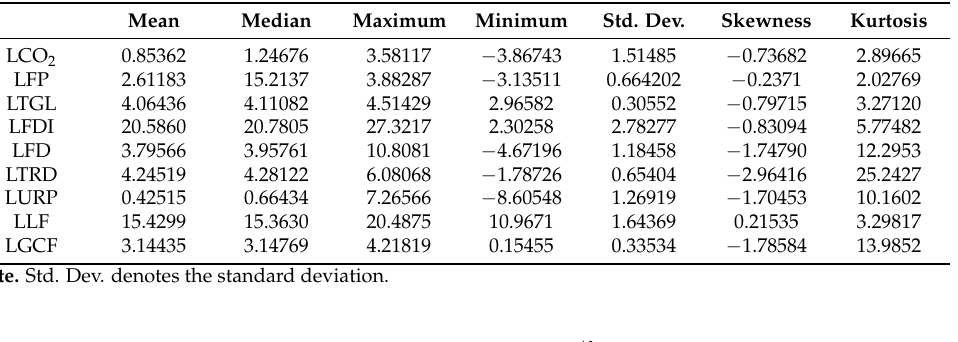
Table 3. Descriptive statistics.